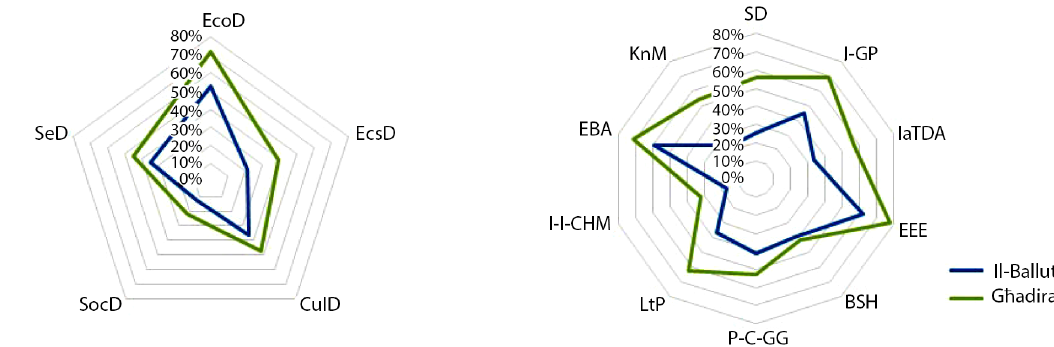
Figure 6. Summary of scorecard footprints of Il-Ballut and Għadira management according to the sustainable development dimensions and ten sustainable development